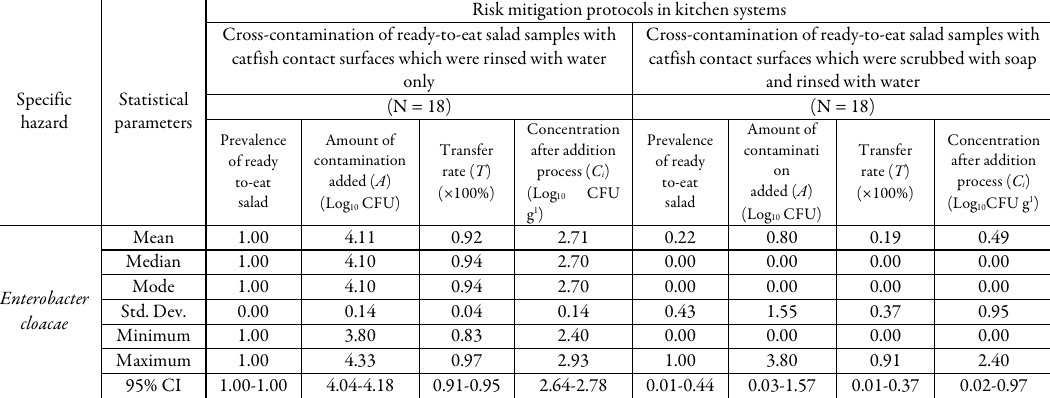
Table 3. Variables inputted into FDA-iRisk software for stochastic quantification of variability in the concentration of the pathogen in cross-contaminated ready-to-eat salad